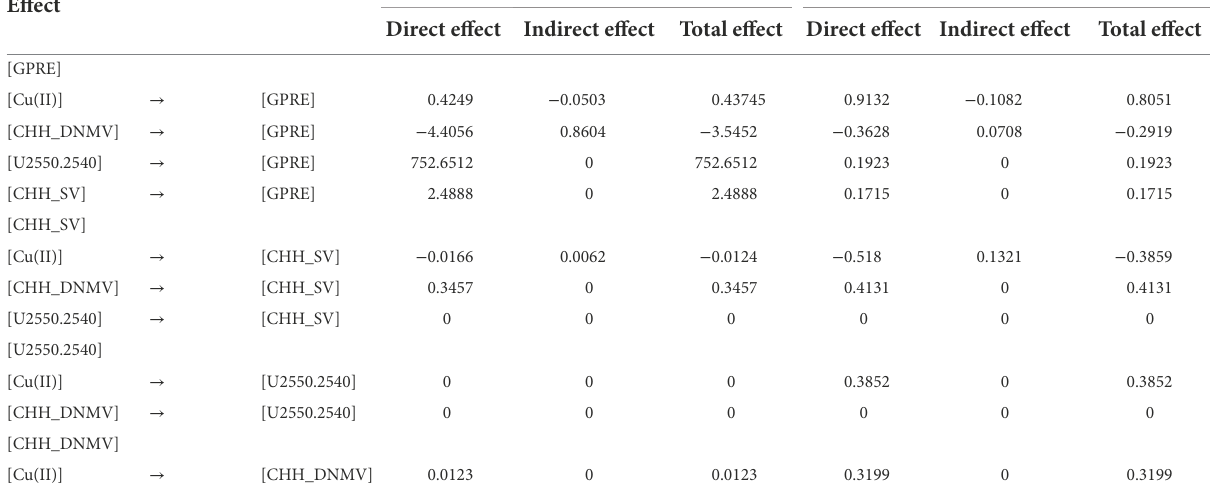
TABLE 6 Direct, indirect, and total effects for the analyzed